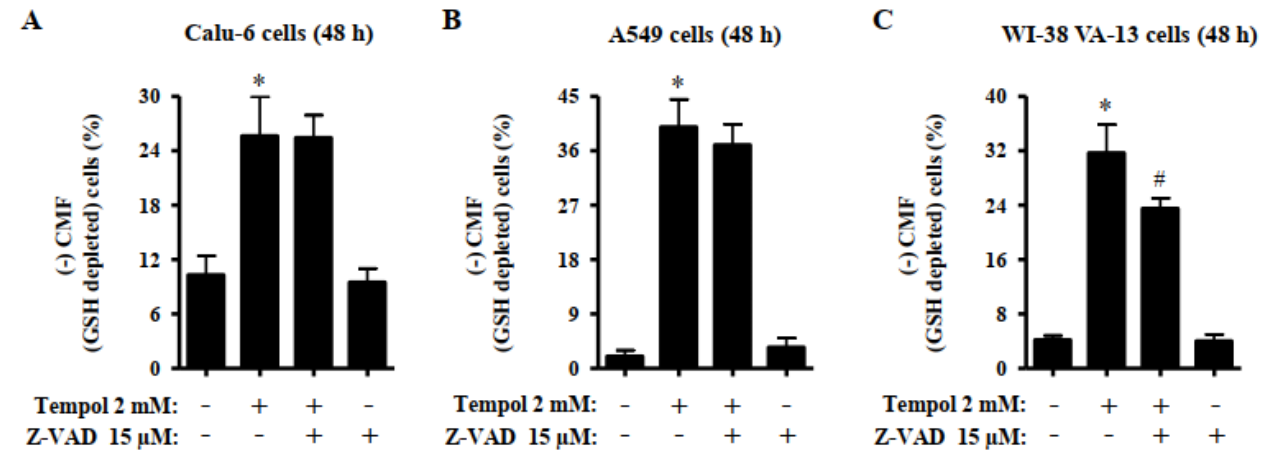
Figure 7. Effects of Tempol and/or Z-VAD on intracellular GSH depletion in Calu-6, A549, and WI-38 VA-13 cells. Exponentially growing cells were pretreated with Z-VAD for 1 h and then treated with 2 mM Tempol for 48 h. The intracellular CMF (GSH) levels in lung cells were measured using a FACStar flow cytometer. The graphs indicate the percentages of (-) CMF (GSH-depleted) Calu-6 cells ( A ), A549 cells ( B ), and WI-38 VA-13 cells ( C ). ANOVA test was used. * p < 0.05 compared to Tempol-untreated control cells. # p < 0.05 compared to cells treated with Tempol only.